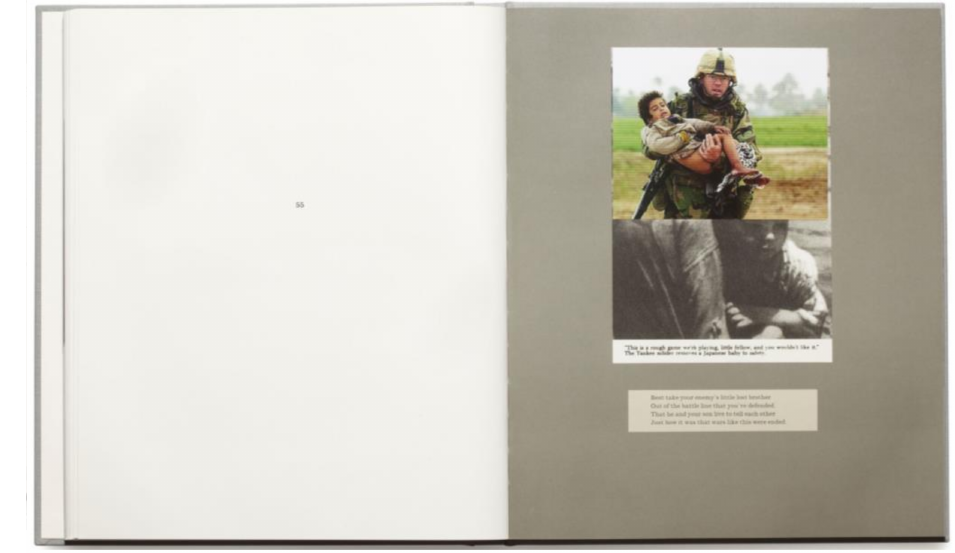
Figure 7. Plate 55. Broomberg & Chanarin. 2011. War Primer 2.